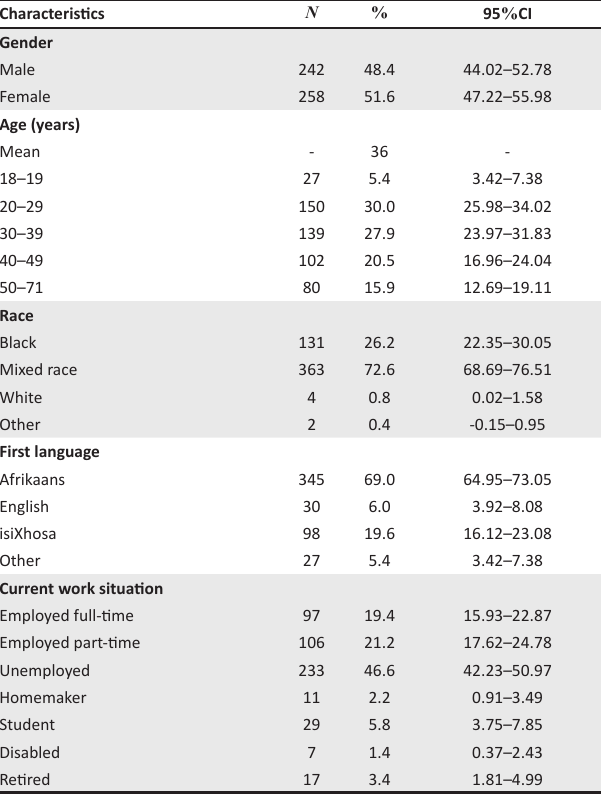
FIGURE 1: Area under the curve.